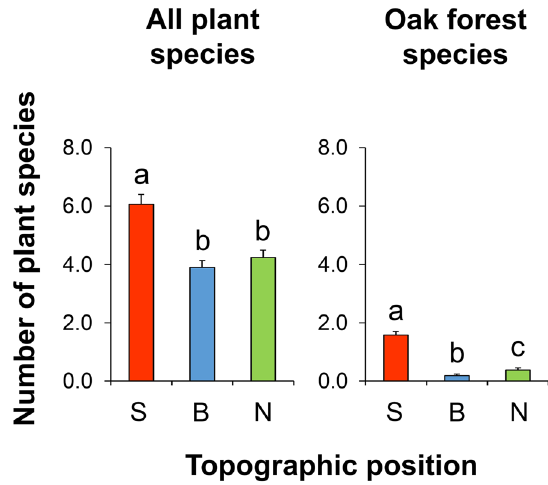
Fig. 5 Number of vascular plant species (all plant species and oak forest species) in the plots of topographic positions in dolines (S: south-facing slope, B: bottom, and N: north-facing slope) (mean SE). Significant differences ( p < 0.05, based on the GLMMs with ± Bonferroni post hoc tests) are indicated by different lower case